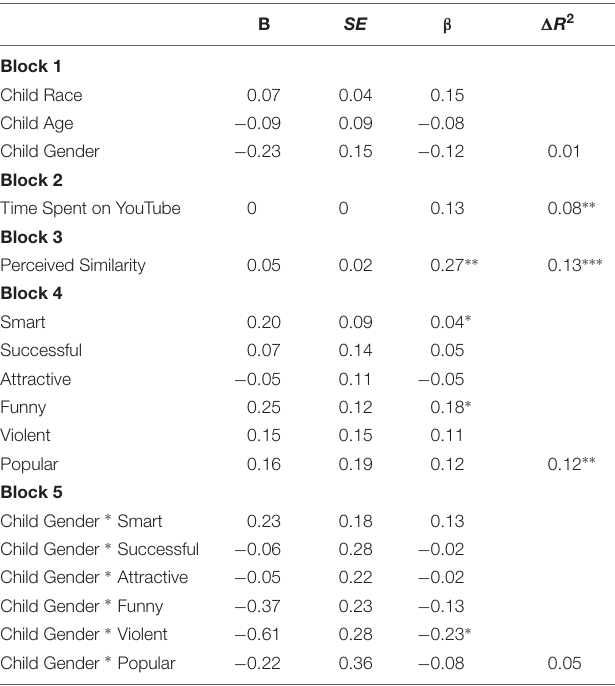
TABLE 4 | Summary of hierarchical regression for attributes predicting wishful identification as moderated by child